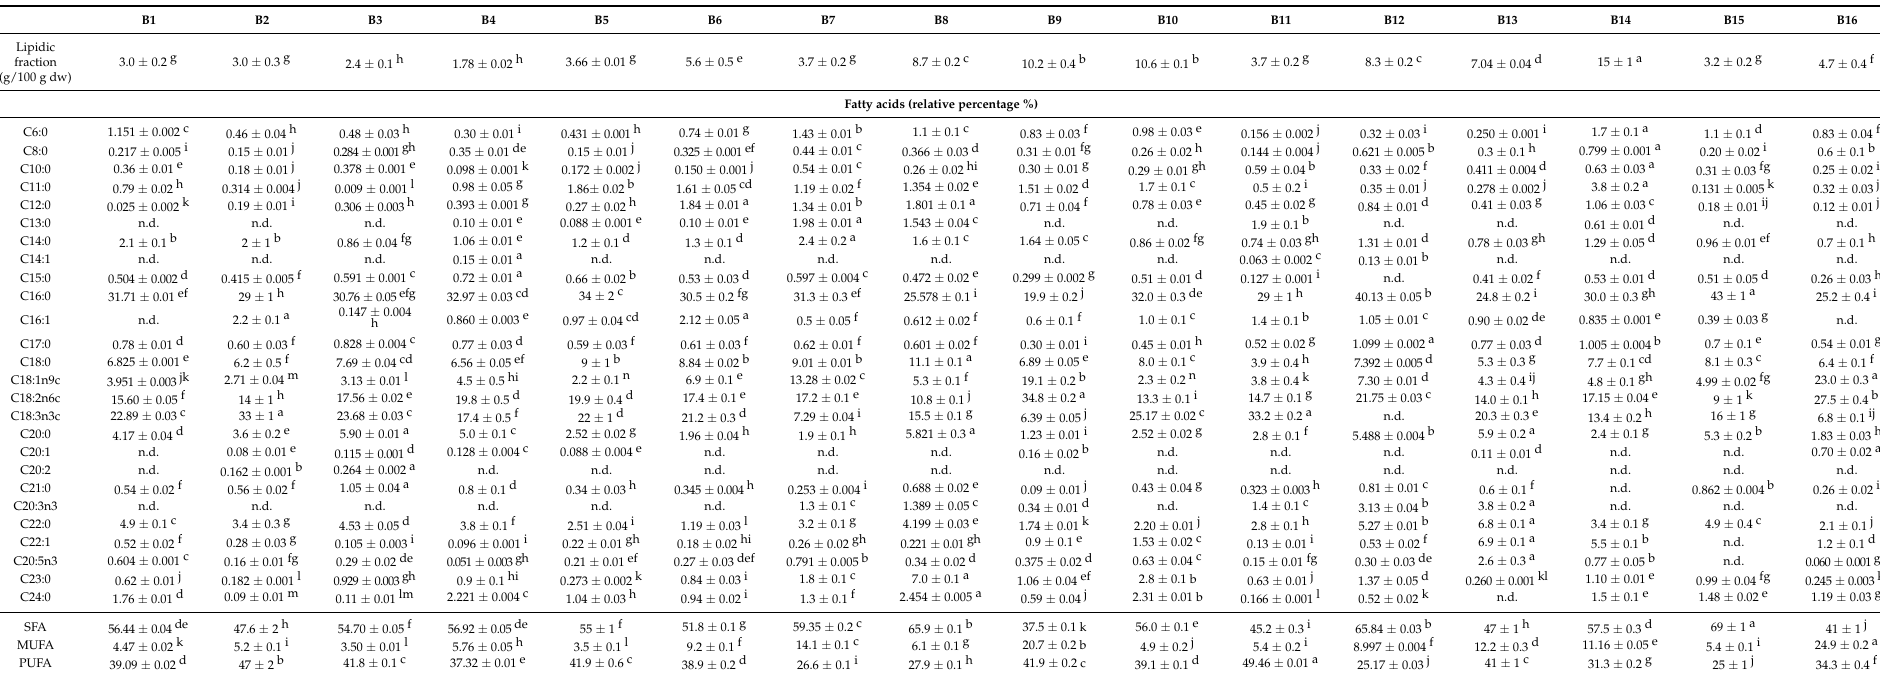
Table 1. The lipidic fraction content (g/100 g dw) and the fatty acids’ composition (%) in cardoon blades collected at different growth